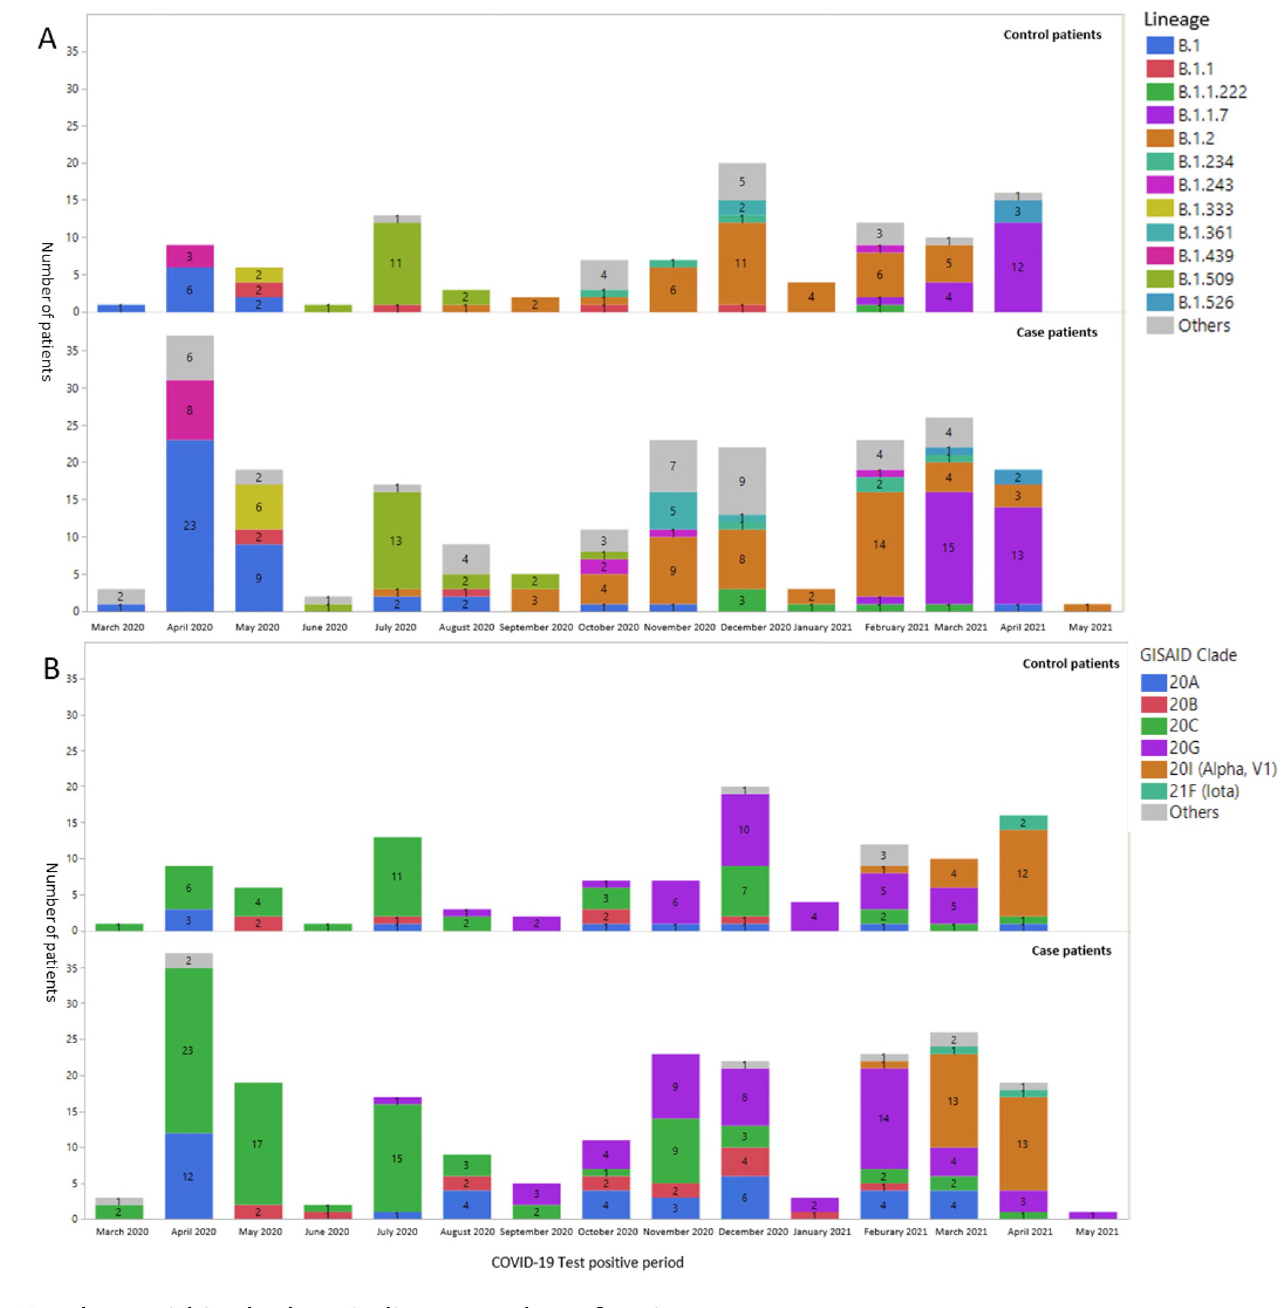
Fig 2. Emergence of SARS-CoV-2 lineages (Panel A) and clades (Panel B) over the study period (March 2020 to May 2021), comparing control vs. case patients (mild vs. severe COVID-19) at